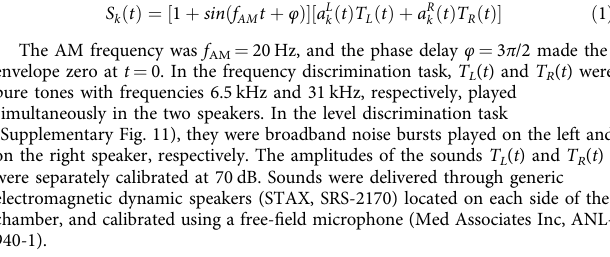
(Fig. 1d, top). Finally, the amplitudes a L k ð t Þ and a R k ð t Þ of the two AM envelopes